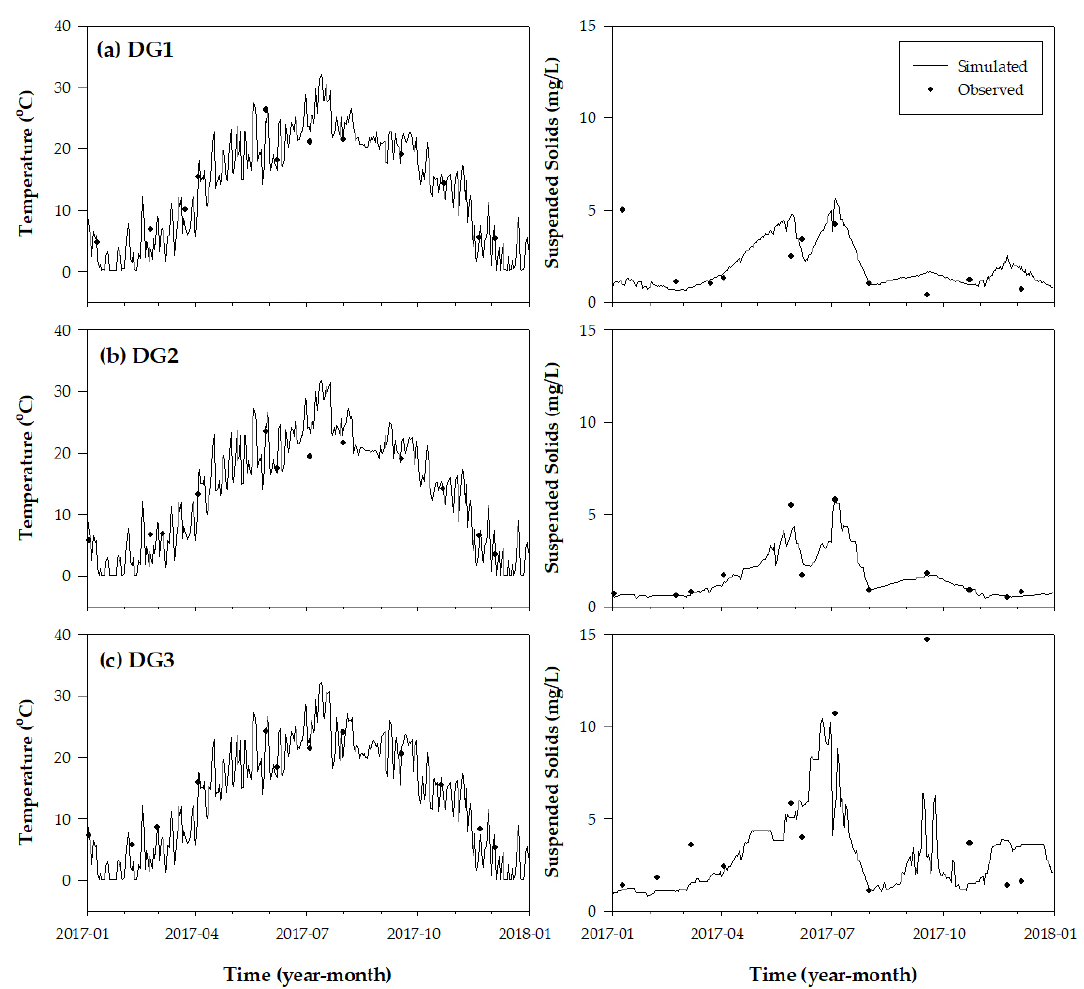
Figure 3. Results of the EFDC model calibration for the temperature and suspended solids (SS) concentration in Kangnung Namdae Stream at ( a ) DG1, ( b ) DG2, and ( c ) DG3.